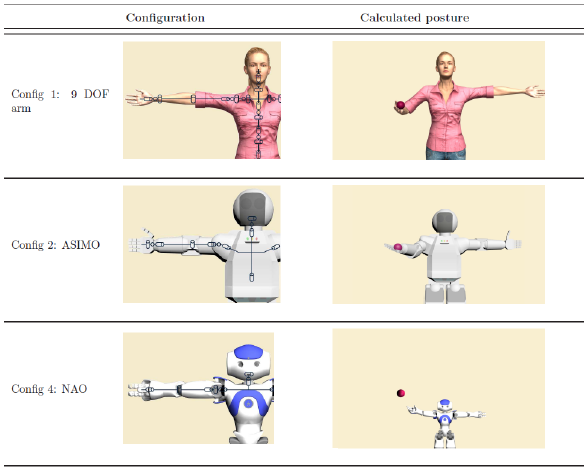
Figure 14: Results of the method for different arm configurations. The first column shows the joint configuration, while the second column shows the end posture for a place-at gesture at (34, −34, 38)